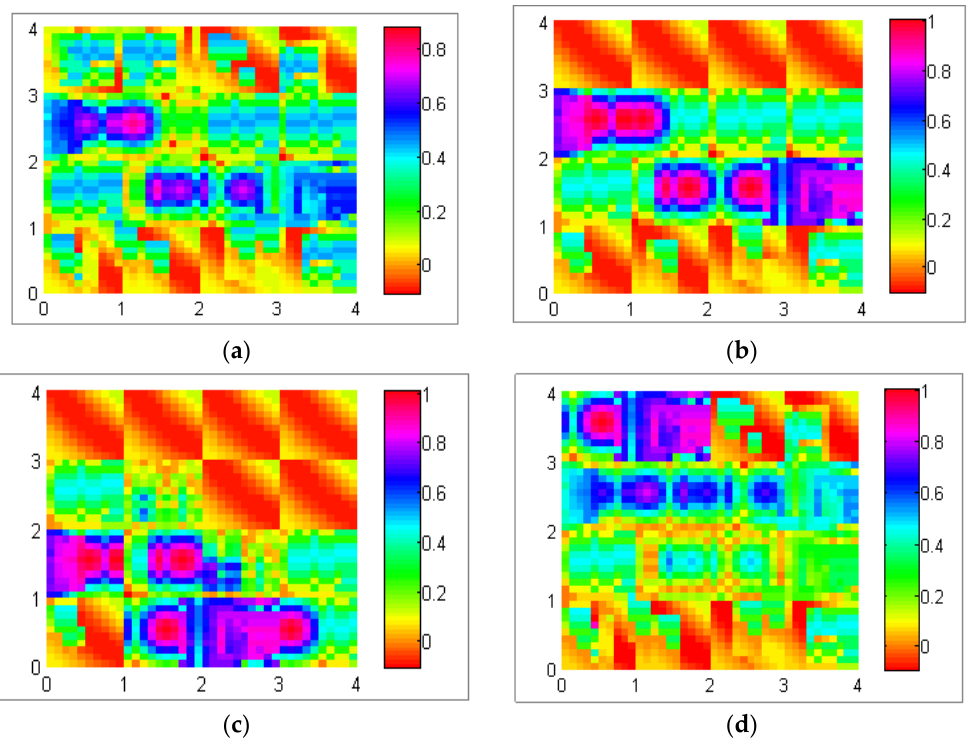
Figure 12. ( a ) Uniform distribution; ( b ) central distribution; ( c ) lower bound distribution; and ( d ) upper bound distribution.